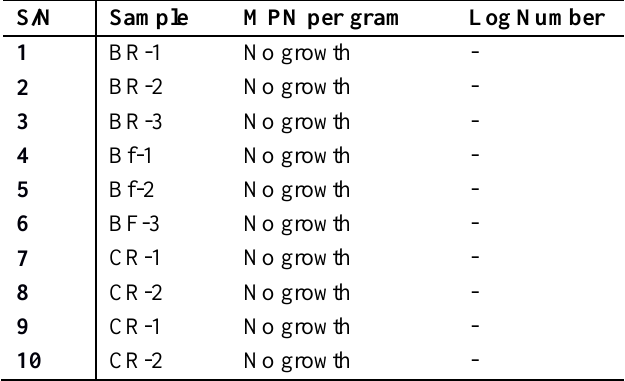
KEY: BR=Roasted beef meat; BF=Fried beef meat; CR= roasted Chicken meat; CF=Fried chicken meat.